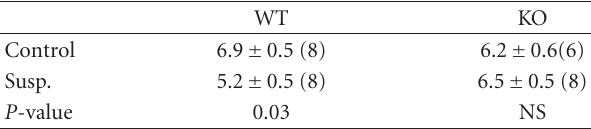
Figure 2: Cross-sectional analysis of soleus muscle. The cross- section of wt soleus muscle is significantly reduced during hindlimb suspension (wt sus), but not in the MuRF1-KO mice. “ ∗ ” indicates statistical significance and “NS” its absence. Table 1: Soleus weights (mg).